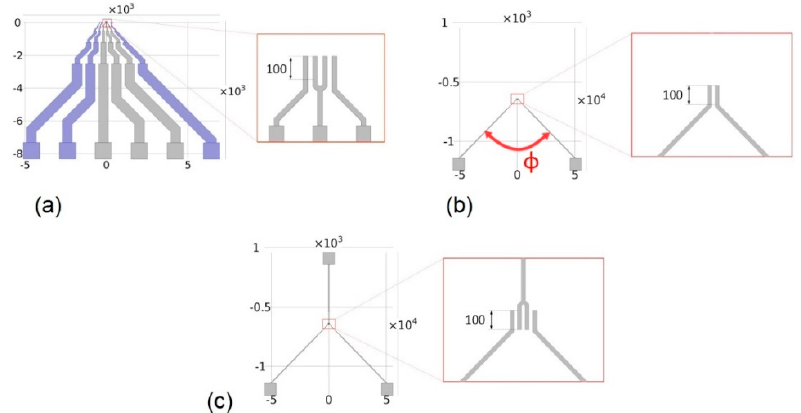
Figure 3. ( a ) Tracks design of the first sensor generation, ( b ) tested design, and ( c ) final design selected for the second sensor generation (scale in µm).